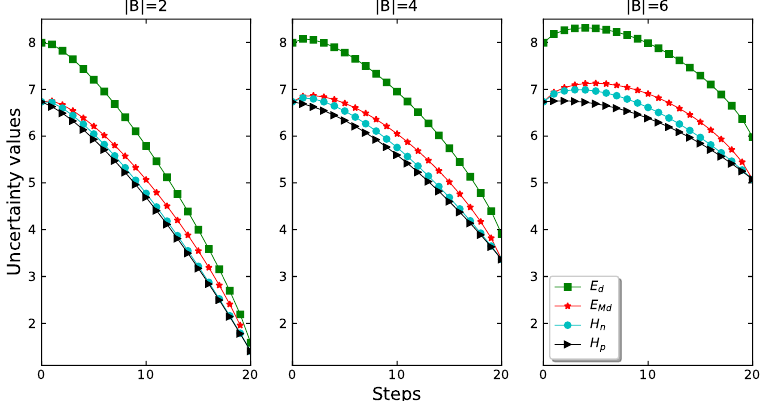
Figure 5. The change of uncertainty values in Example 8.